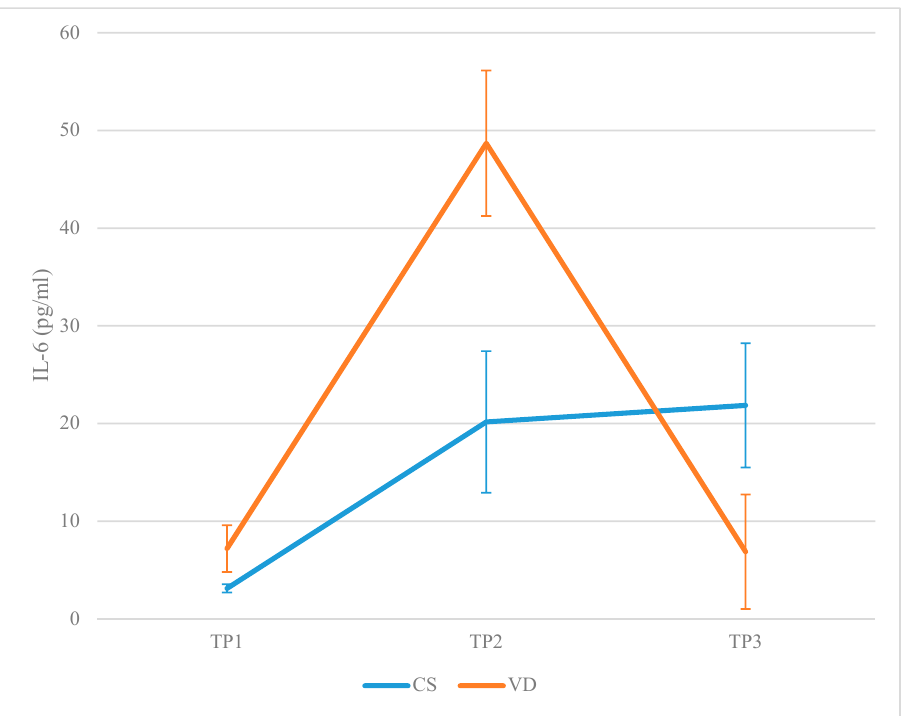
Figure 2. Interleukin-6 (IL-6) levels reported in the CSG and in the VDG, respectively, on each of the